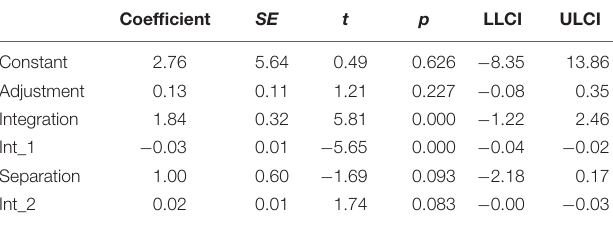
TABLE 5 | Moderation model with turnover intention as dependent variable.